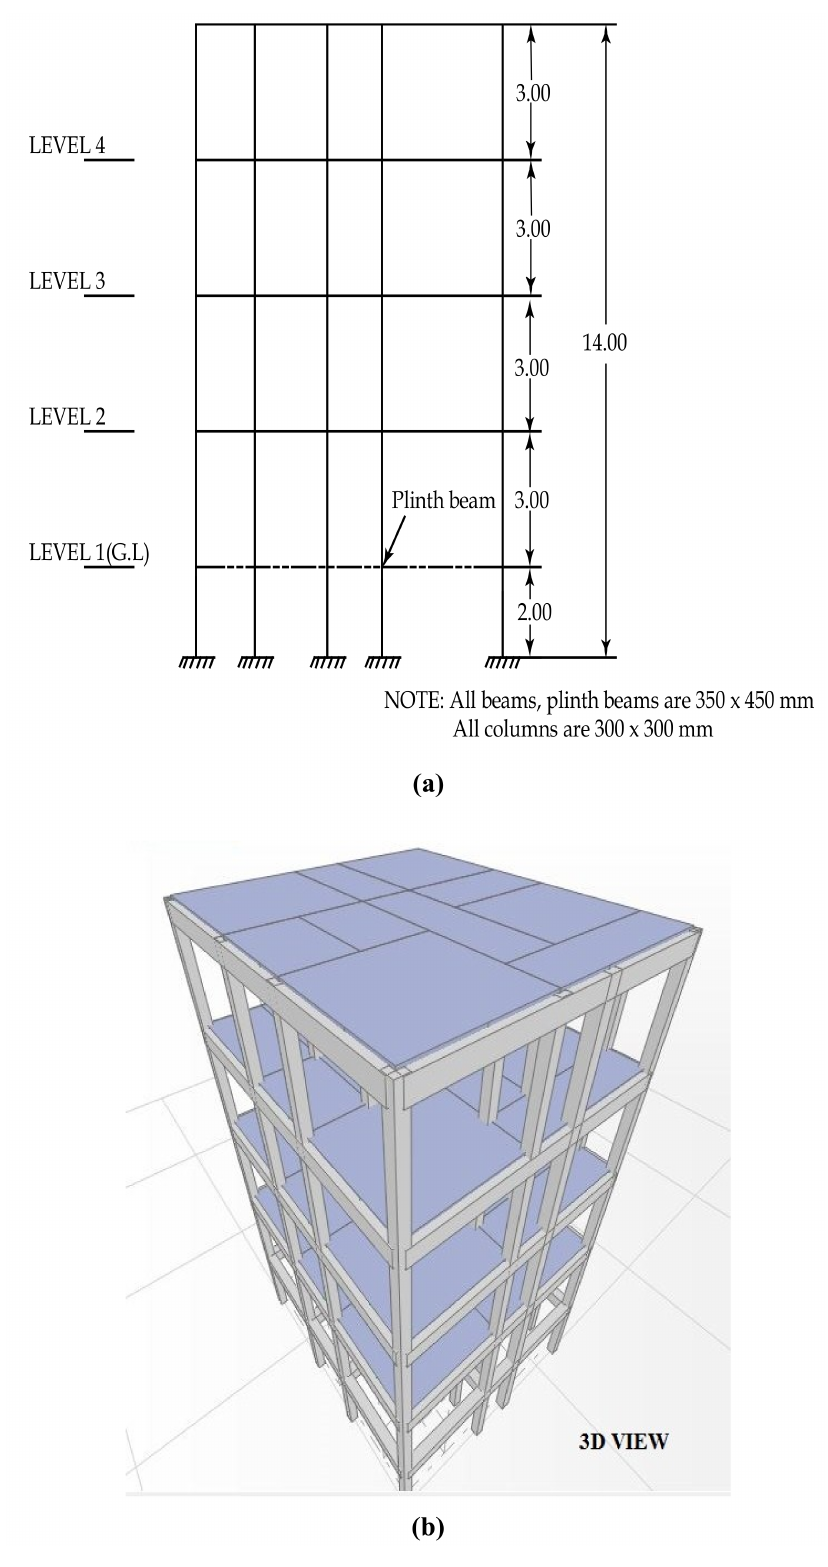
Figure 2. ( a ) Cross-sectional elevation of building with beams and column size, ( b ) SAP2000 three dimensional (3D)